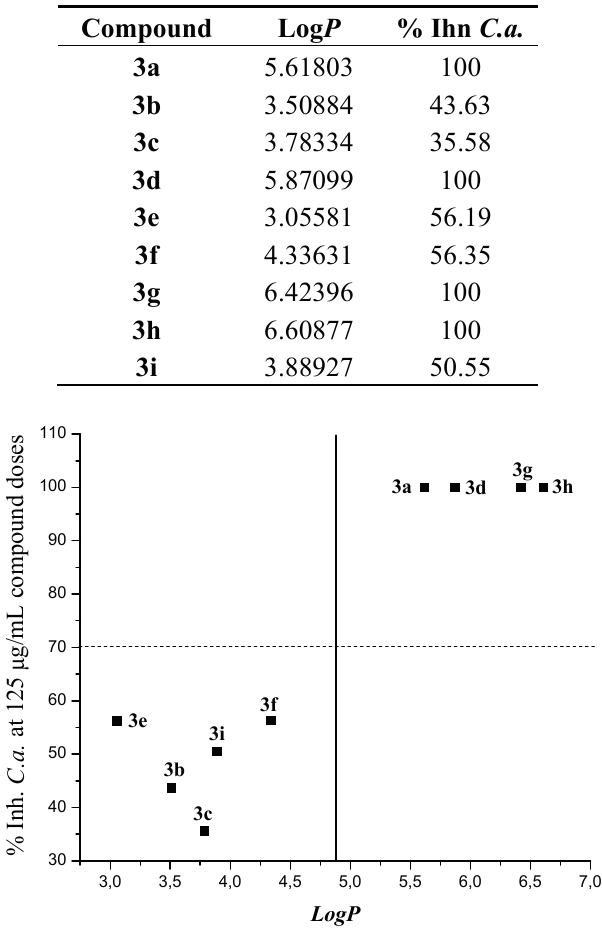
Table 4. In vitro activity of compounds 3a – i expressed as % inhibition of Candida